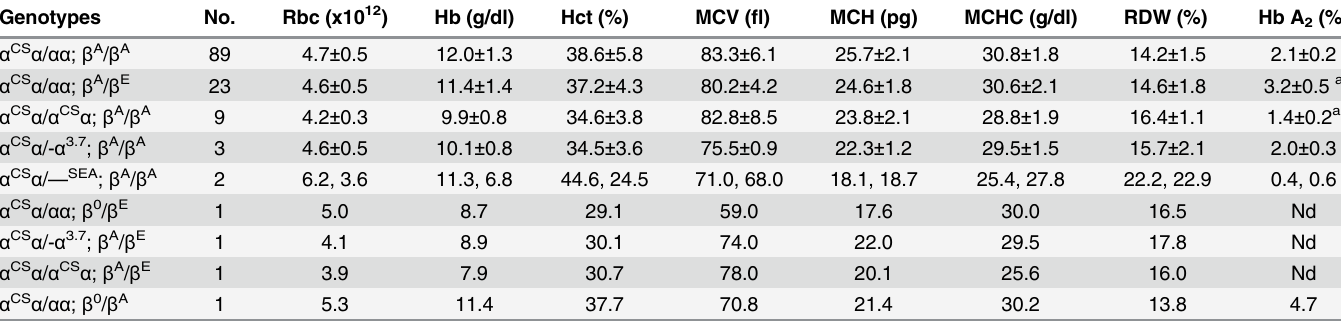
Table 1. Hematological parameters and genotypes of Vietnamese and Laotian subjects with Hb CS (n = 130). Data are presented as mean ± standard deviation or as raw data where appropriate. Nd: not determined. Genotypes